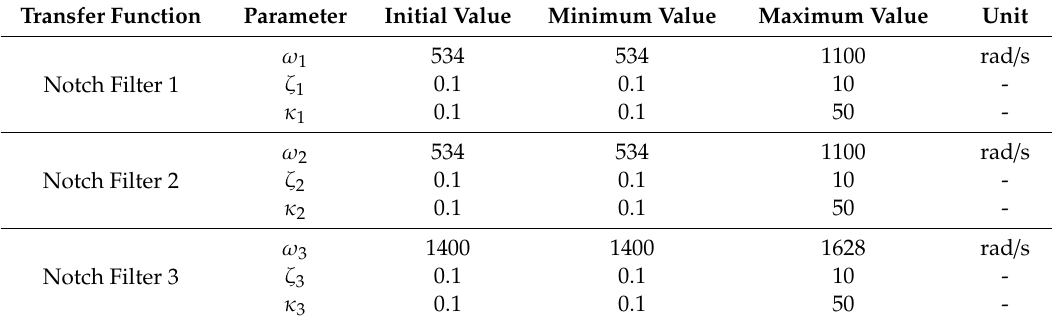
Table 2. The sets of the notch filters for PSO optimization. Transfer